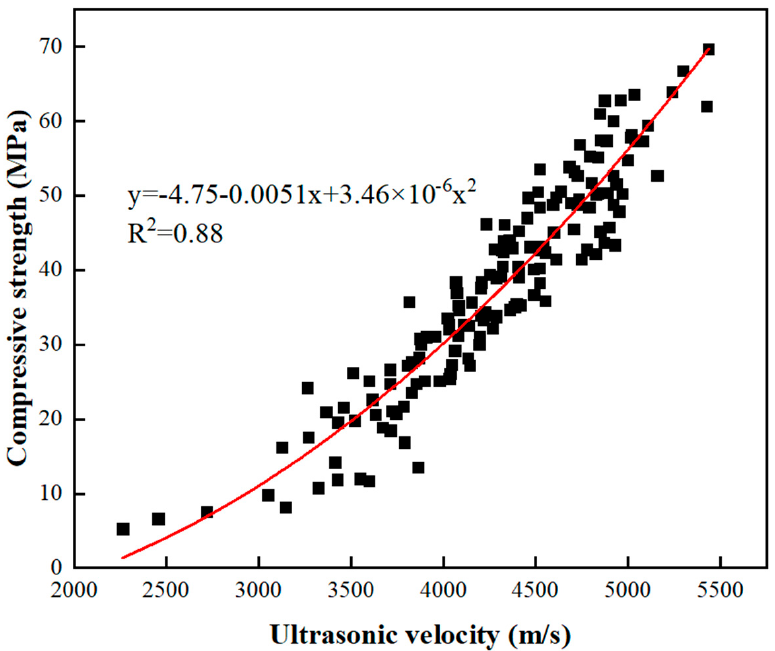
Figure 11. Regression analysis of compressive strength and ultrasonic wave velocity of green and ecofriendly grouting material.